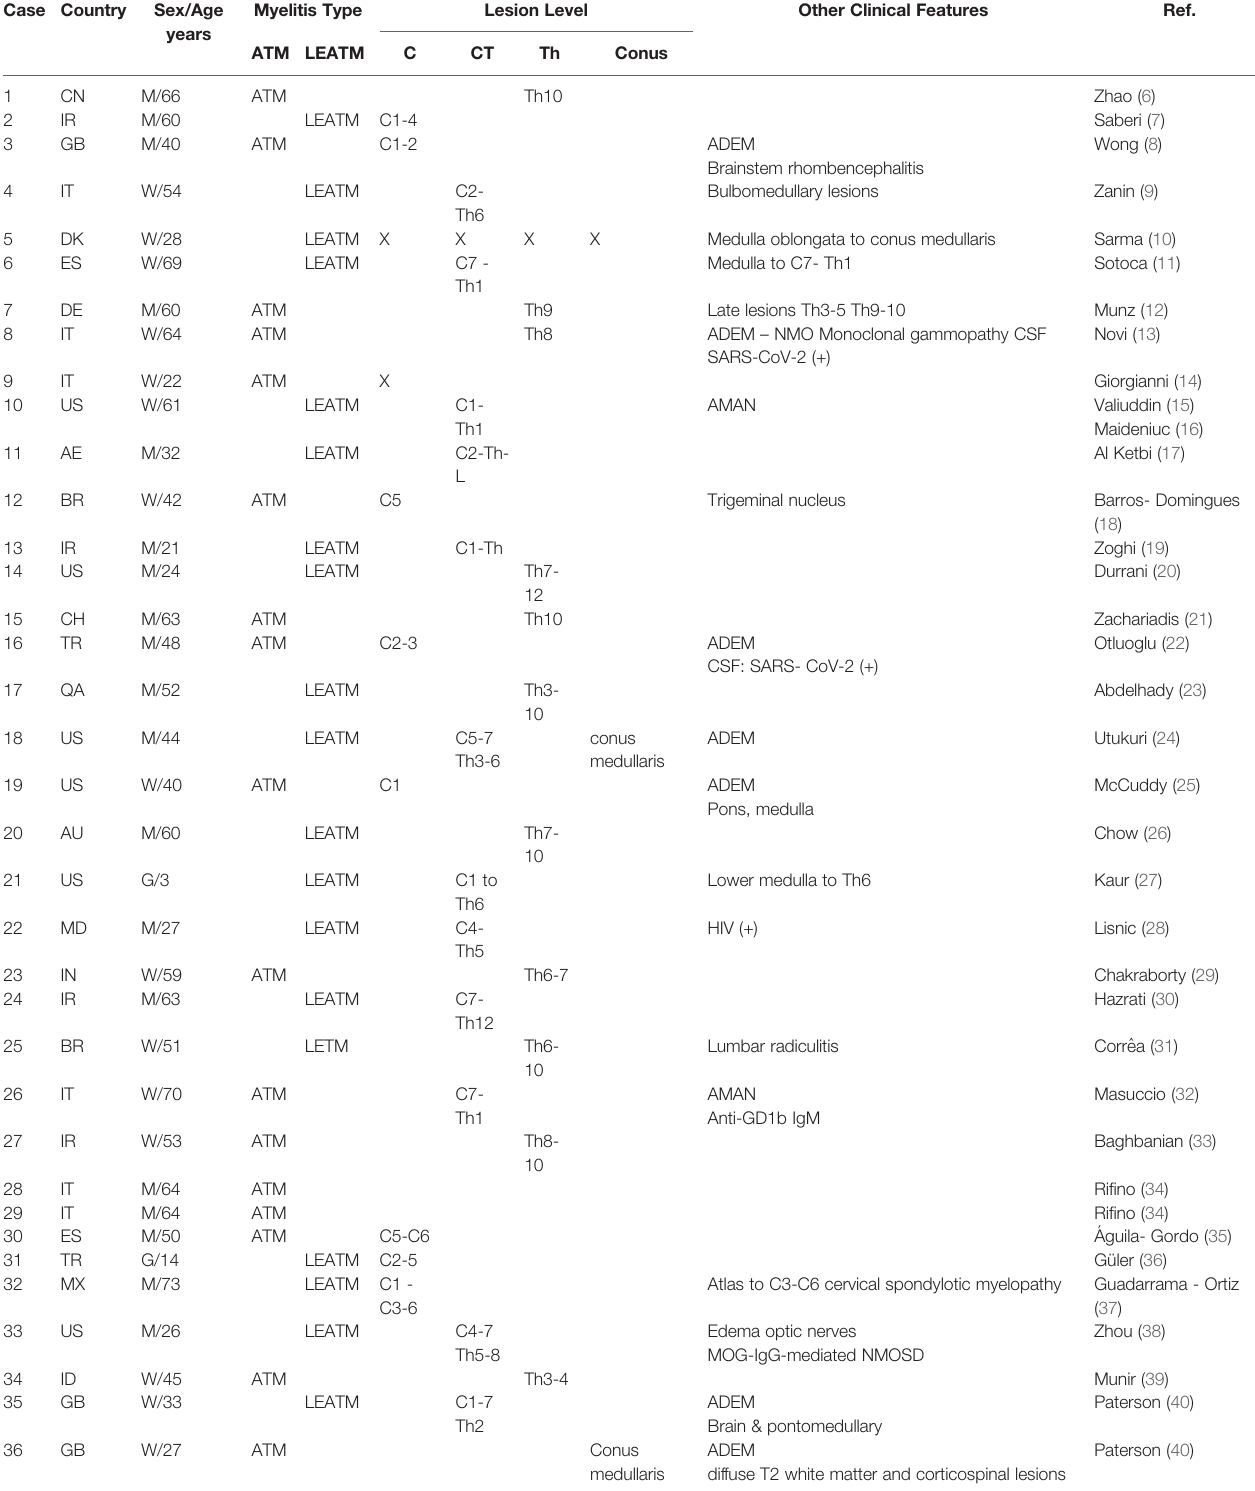
TABLE 1 | Summary of SARS-CoV-2-Associated Myelitis Published Cased from March-2020 until January-2021. Case Country Other Clinical Features